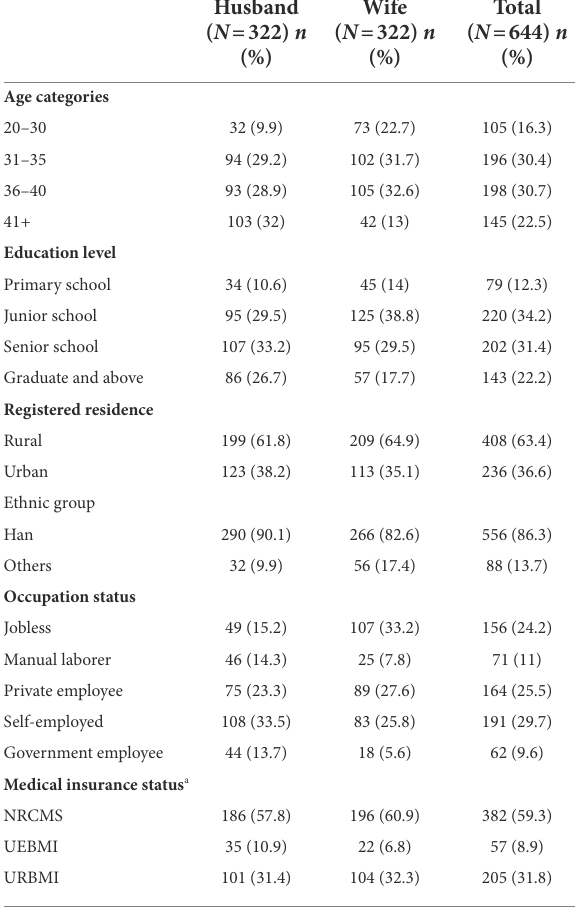
TABLE 1 Socio-demographic of couples living with